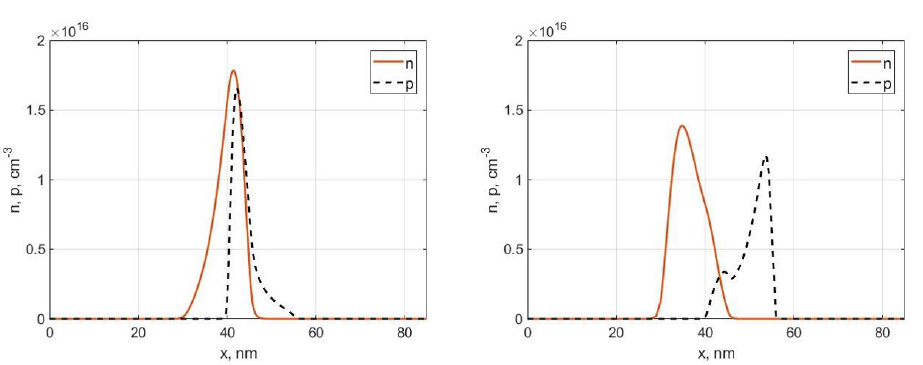
Fig. 3. The spatial overlap (left plot) and separation (right plot) of electron ( n ) and hole ( p ) density peaks in the photodetector shown in Fig. 1. The control voltage equals to 0 (leading edge of a laser pulse) for the left plot and to constant non-zero value (back edge of a laser pulse) for the right plot.